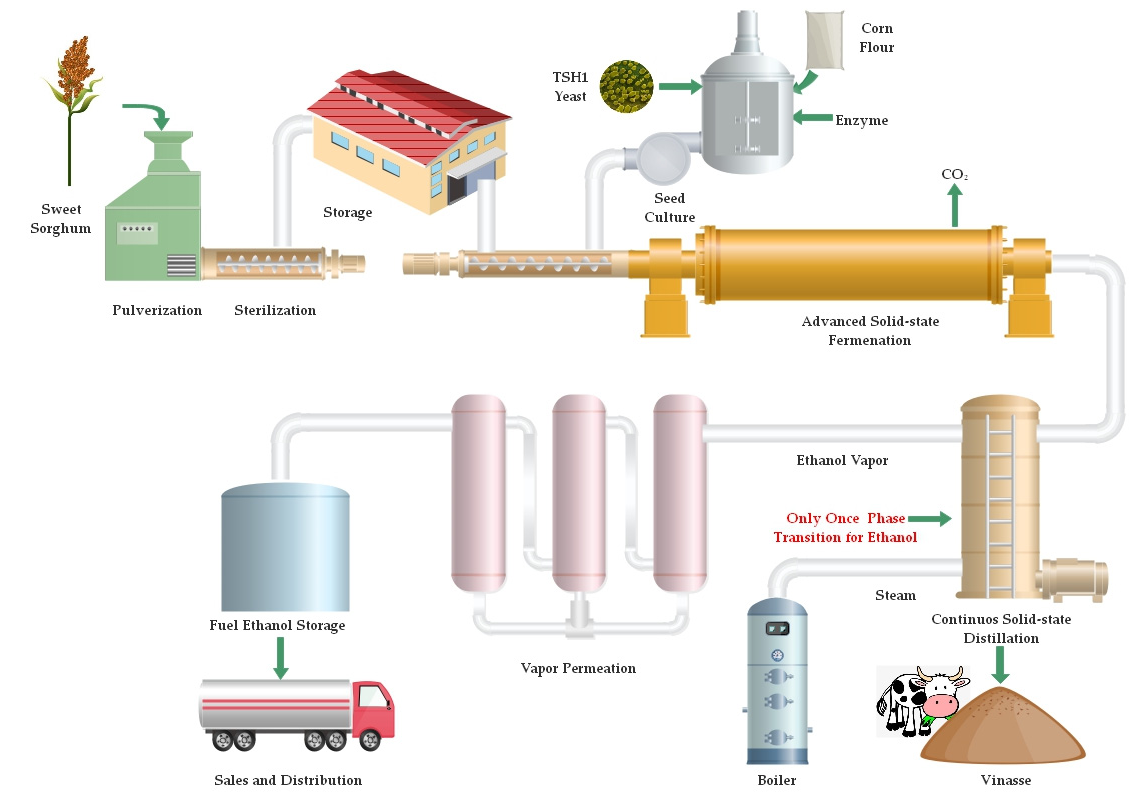
Figure 2. One phase transition separation processing flow diagram.